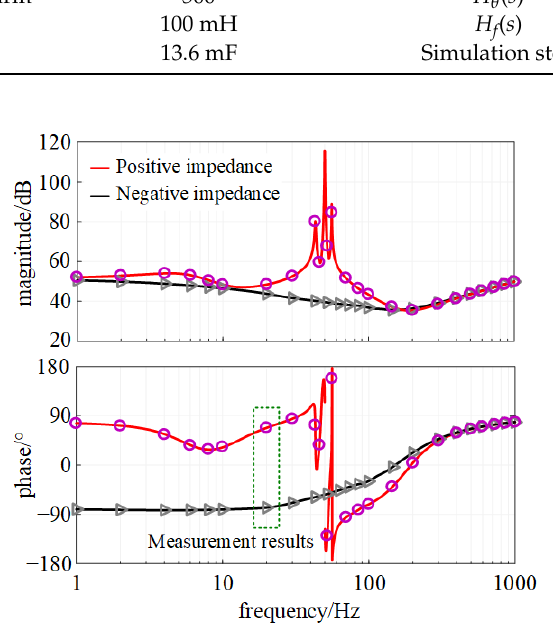
Figure 2. Frequency responses of ZMMC(s).